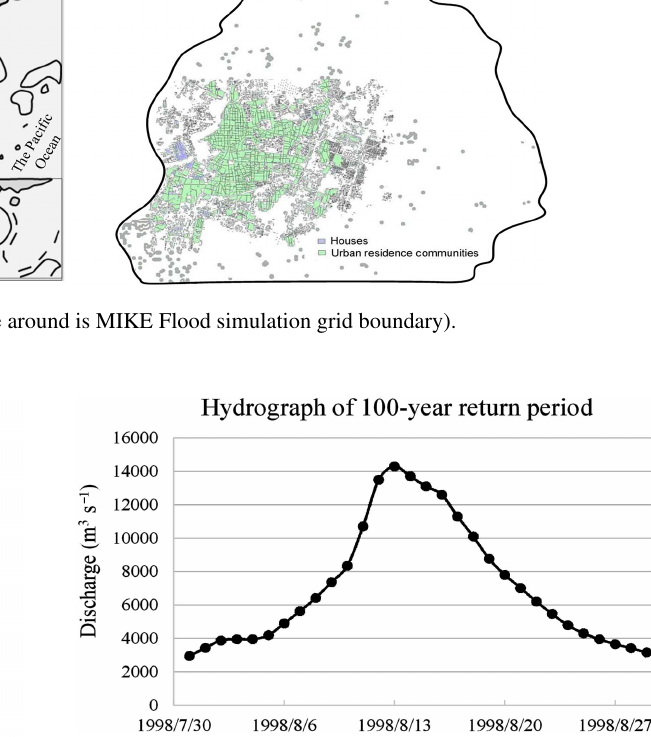
Figure 5. Design flood hydrograph of 100-year return